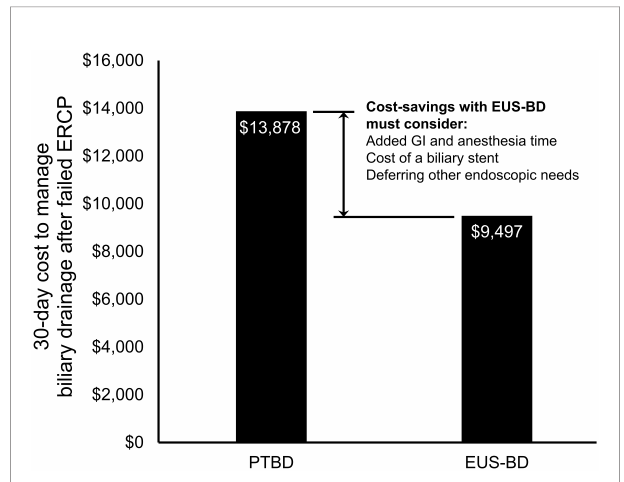
FIGURE 1 | Total US Medicare reimbursement (i.e., costs to Medicare) with EUS-BD compared to PTBD. In base-case analysis, EUS-BD is cost-saving to Medicare compared to PTBD to achieve successful biliary drainage due to a biliary obstruction in patients with a failed ERCP. EUS-BD, endoscopic ultrasound-guided biliary drainage; PTBD, percutaneous transhepatic biliary drainage; ERCP, endoscopic retrograde